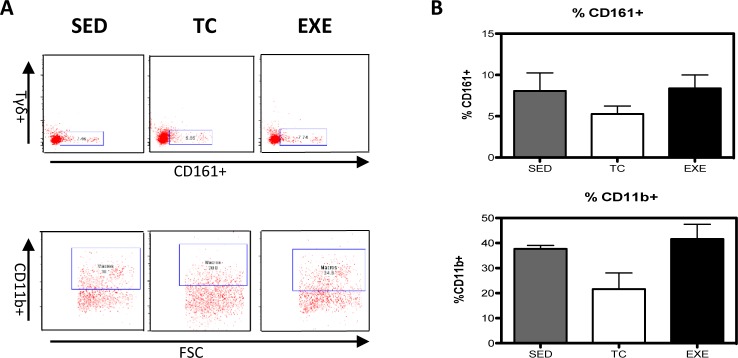
Changes in the composition of splenocyte populations related to the innate immune response.(A) Representative dot plot of the cytometric analysis of the subpopulation percentages. (B) Determination of splenocyte subpopulations from the innate immune response one day after being exposed to each condition in the different groups: SED, TC and EXE; data from 4 independent experiments are expressed as mean ± SE. No subpopulation showed statistically significant changes: Natural killer cells (ANOVA, p = 0.0683, n = 10), and Macrophages (ANOVA, p = 0.0273, n = 10).